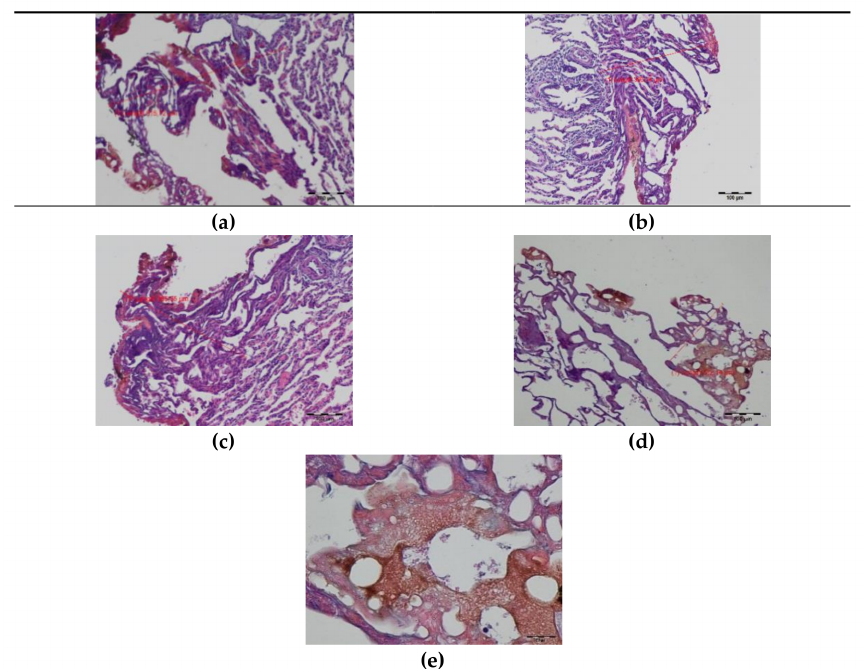
Figure 5. Histopathology of the lung tissue after a thulium-doped fiber laser (TDFL) cut on day 0: ( a , b , c ) total zone of laser thermal damage, magnification 100×; ( d , e ) superficial zone of laser ther- mal damage, magnification 100× and 400×; HE staining.